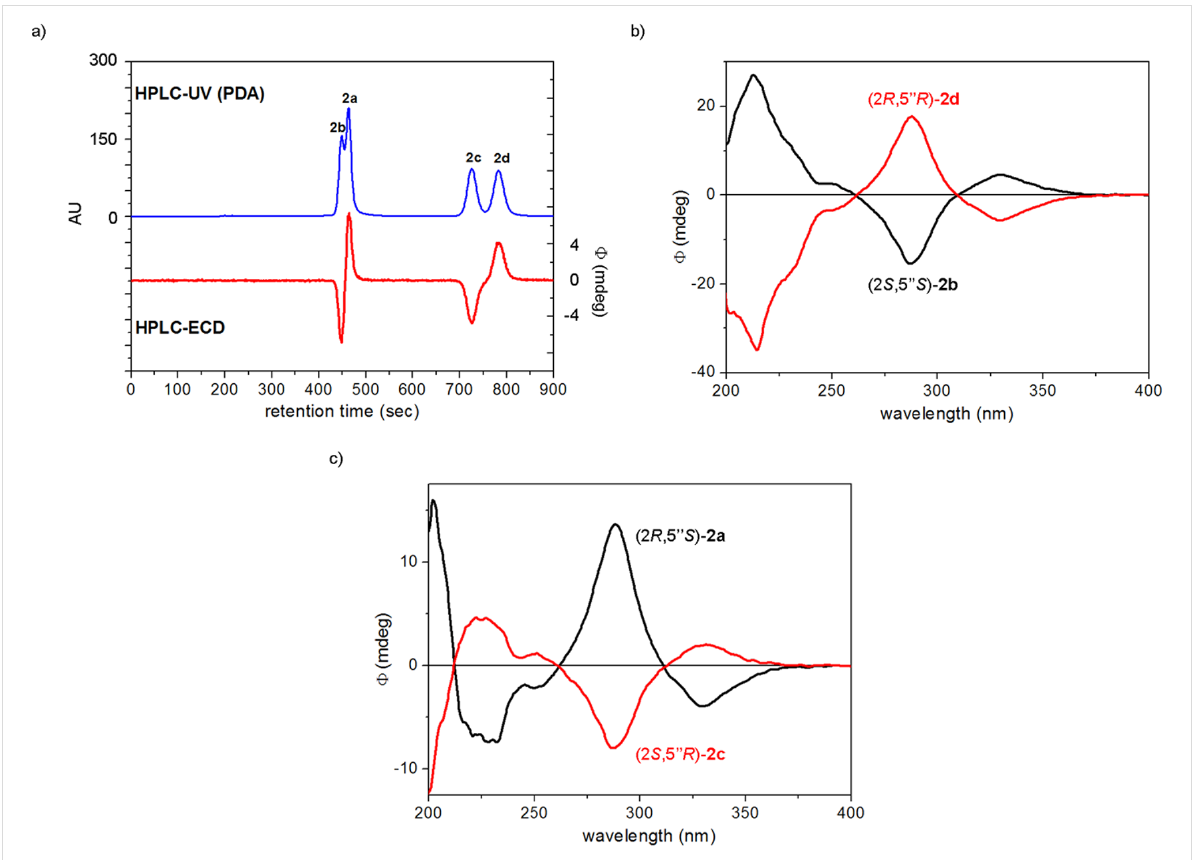
Figure 2: a) Chiral HPLC–UV and HPLC–ECD traces of dracocephins A ( 2a – d ) using Chiralpak IC column with the eluent MeCN/2-propanol/TFA 97:3:0.1 monitored at 290 nm. b) HPLC–ECD spectra of the first [black: (2 S ,5” S )- 2b or dracocephin A2] and fourth eluted [red: (2 R ,5” R )- 2d or draco- cephin A4] stereoisomers of dracocephins A. c) HPLC–ECD spectra of the second [black: (2 R ,5” S )- 2a or dracocephin A1] and third eluted [red: (2 S ,5” R )- 2c or dracocephin A3] stereoisomers of dracocephins A. The absolute configurations were assigned on the basis of the publication